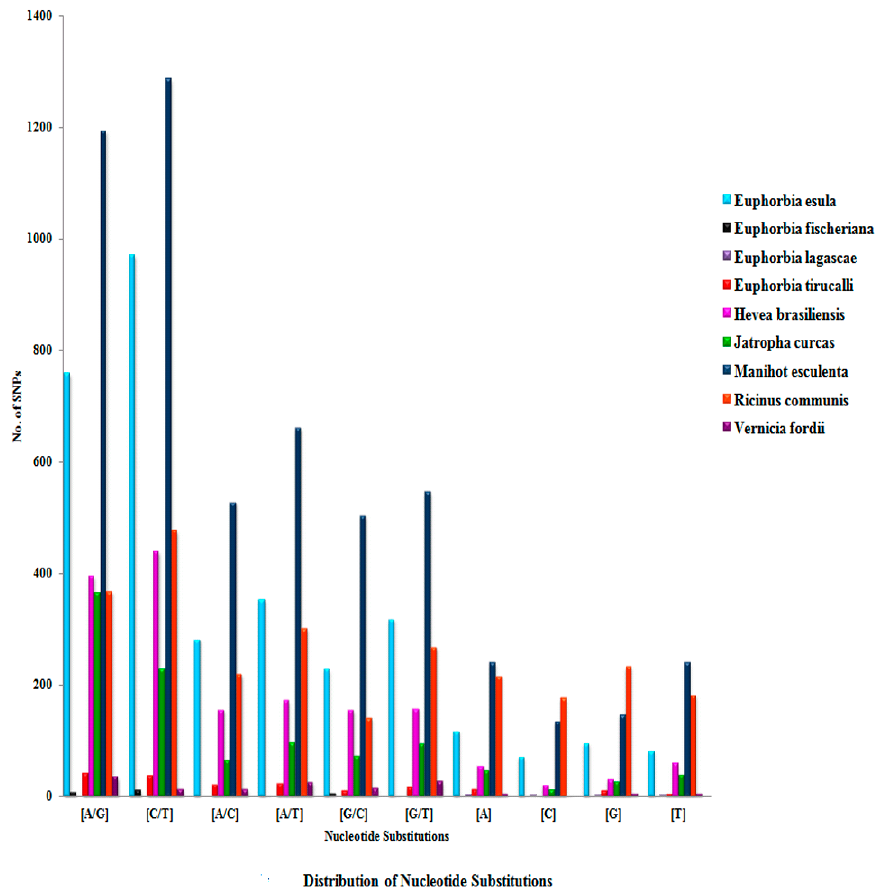
Figure 4. Figure 4. Distribution of nucleotide substitutions in nine selected species belonging to the family Euphorbiaceae.